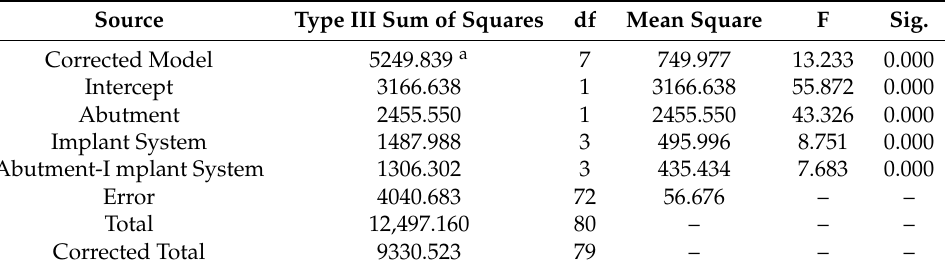
Table 4. Two-way ANOVA results for marginal